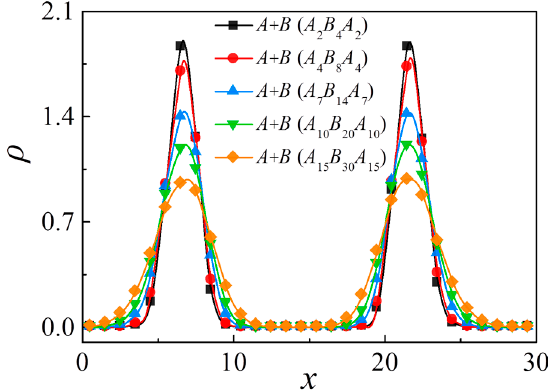
Figure 4. Density profiles of beads A + B of triblock copolymer along x -axis as a function of chain length of copolymer at copolymer concentration of c cp = 0.1.